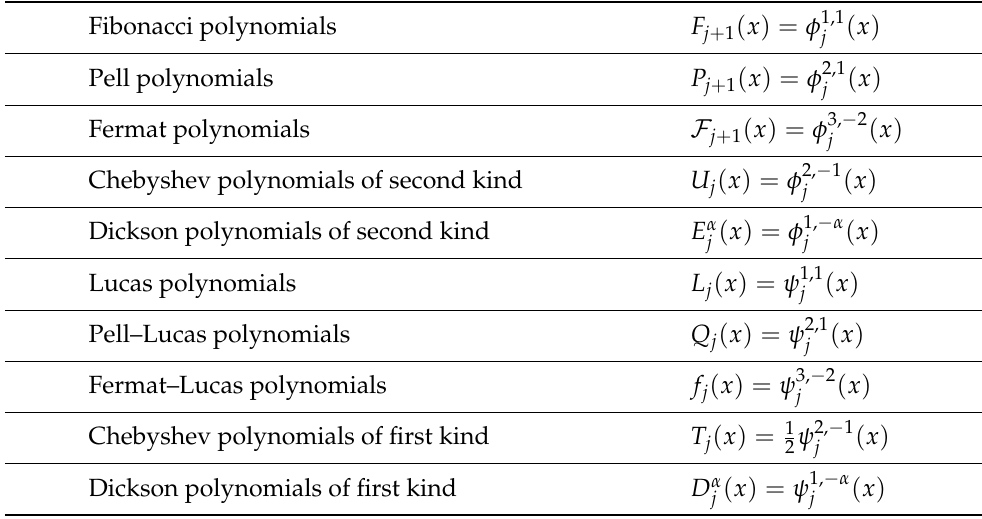
Table 1. Special cases of the two generalizing